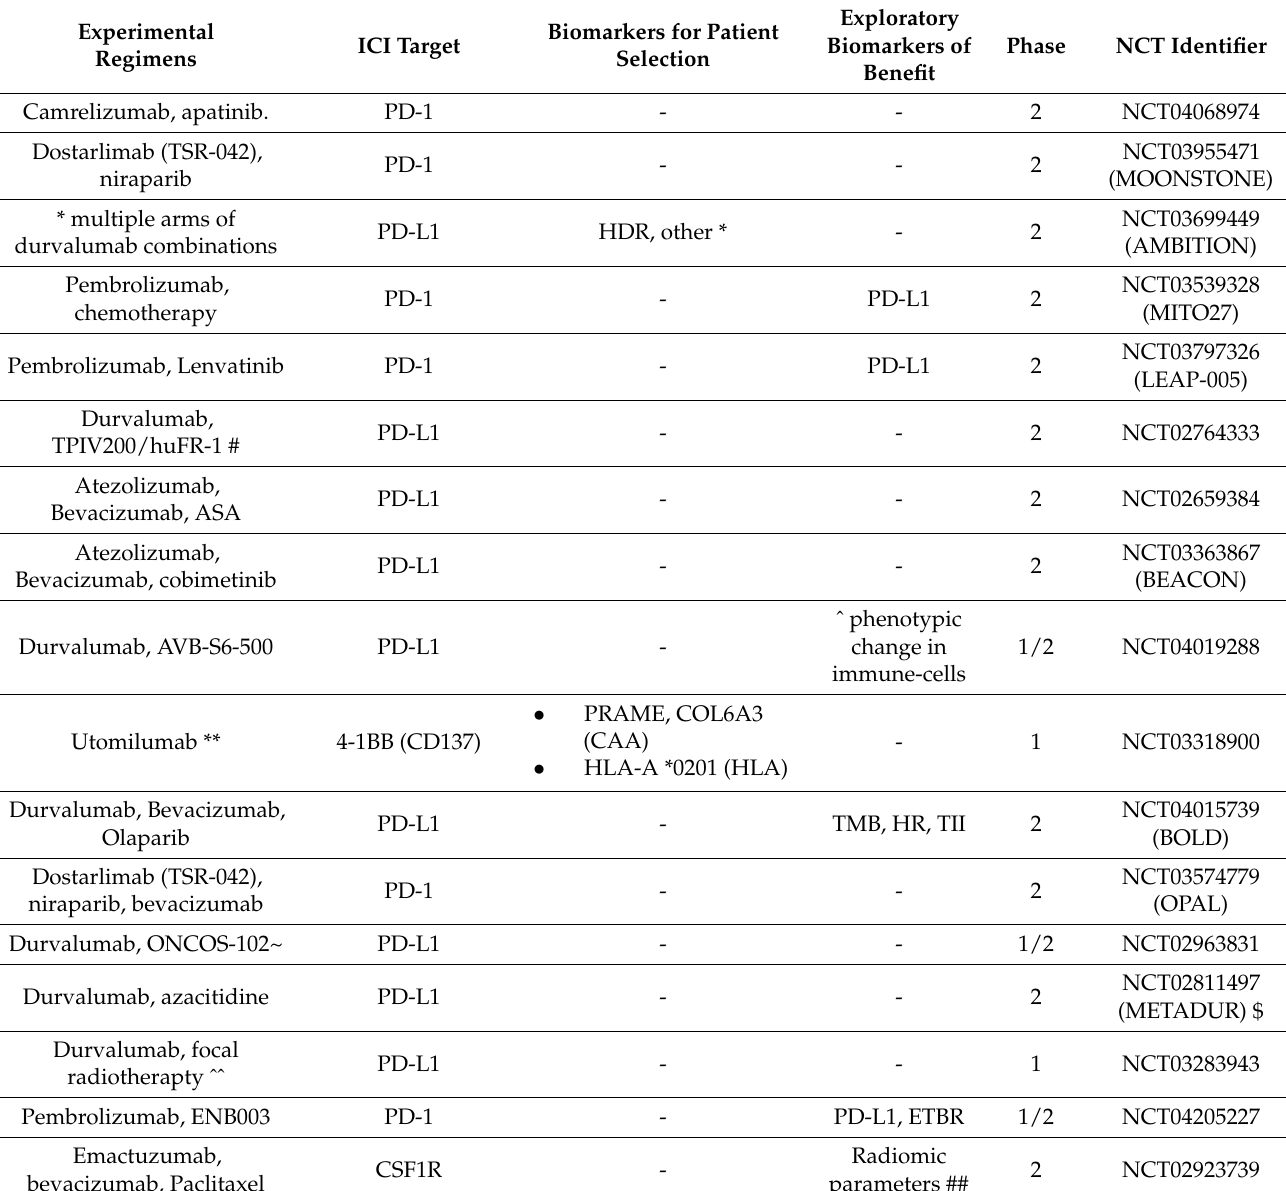
Table 2. Ongoing clinical trials of immune-check point inhibitors in recurrent platinum-resistant ovarian cancer. Experimental Regimens